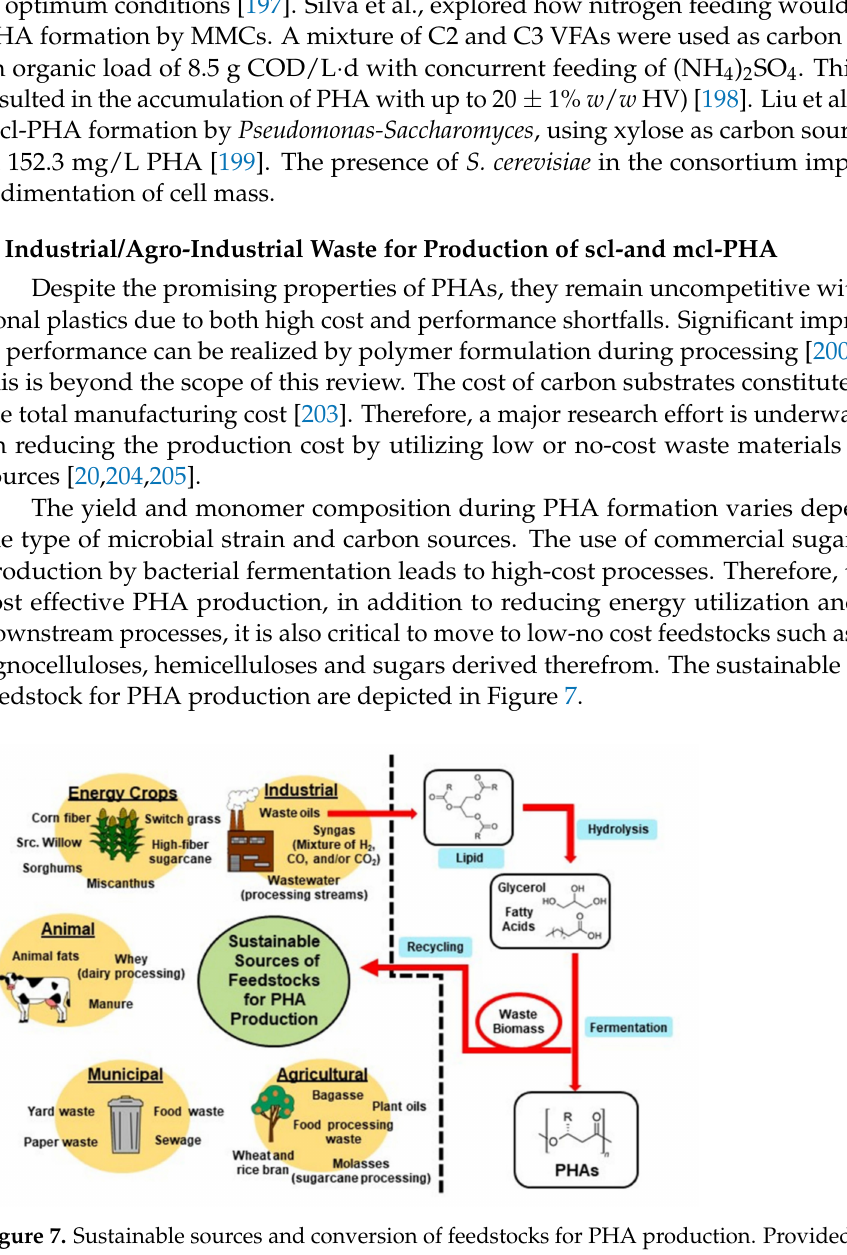
Figure 7. Sustainable sources and conversion of feedstocks for PHA production. Provided within the dashed area is a simplified representation of the conversion of waste oils (lipids) to PHAs. The waste lipid is hydrolyzed to yield substrates for fermentation: fatty acids and glycerol. The substrates are purified prior to use in fermentations. Recovered waste biomass can be recycled as a carbon source for future